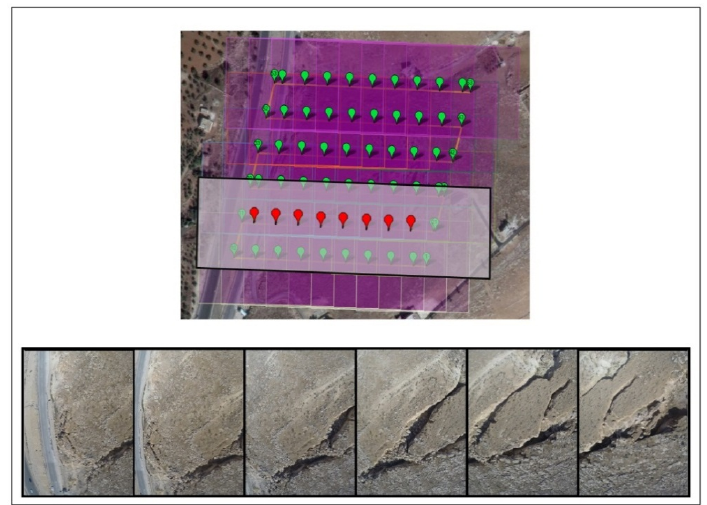
Figure 10. Strip of aerial photographs of the study area captured from the areas indicated in red along of the east-west flight path shown in the upper image.